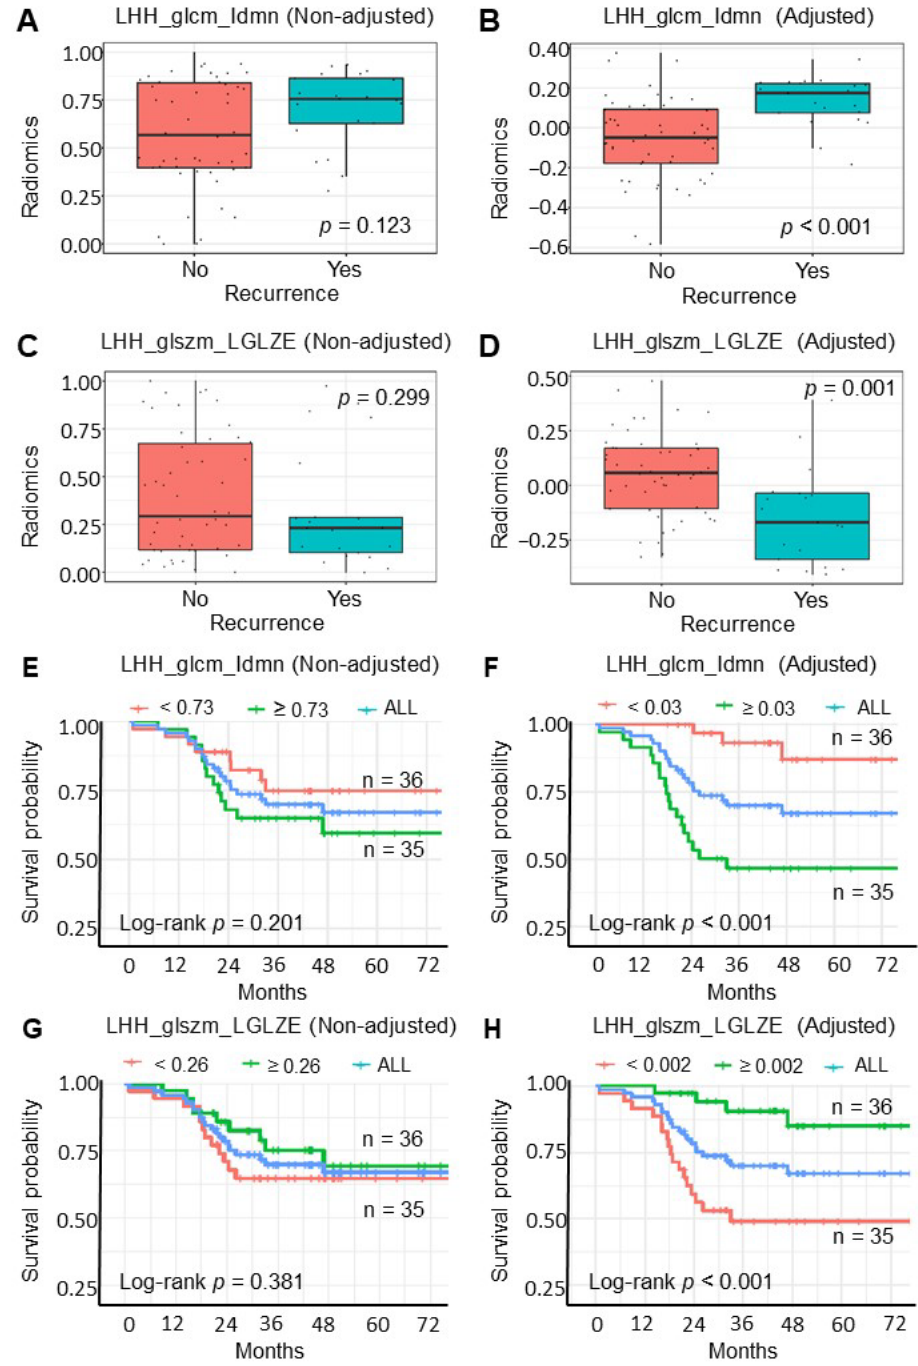
Figure 3. Boxplot and Kaplan–Meier survival curves comparing the risk of cancer recurrence and recurrence-free survival (RFS) among patients with adjusted radiomic features or without radiomic features. ( A ) Boxplot of cancer recurrence in patients without adjusted LHH_glcm_Idmn radiomic features. ( B ) Boxplot of cancer recurrence in patients with adjusted LHH_glcm_Idmn radiomic features. ( C ) Boxplot of cancer recurrence in patients without adjusted LHH_glszm_LGLZE radiomic features. ( D ) Boxplot of cancer recurrence in patients with adjusted LHH_glszm_LGLZE radiomic features. ( E ) Kaplan–Meier survival curves of recurrence-free survival by wavelet LHH_glcm_Idmn without adjusted radiomic features. ( F ) Kaplan–Meier survival curves of recurrence-free survival by wavelet LHH_glcm_Idmn with adjusted radiomic features. ( G ) Kaplan–Meier survival curves of recurrence-free survival by LHH_glszm_LGLZE without adjusted radiomic features. ( H )